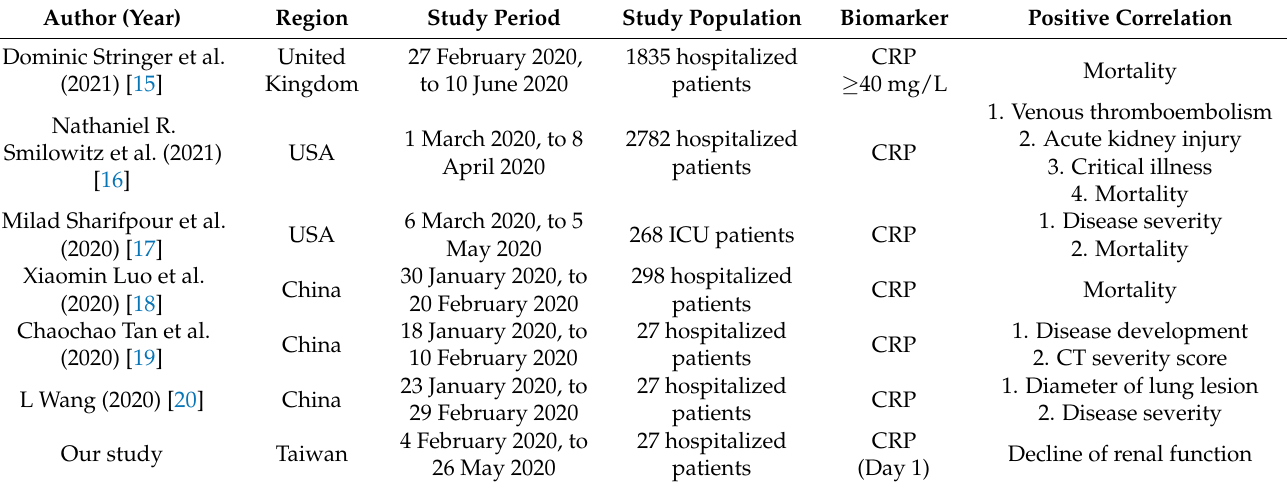
Table 6. The role of CRP in